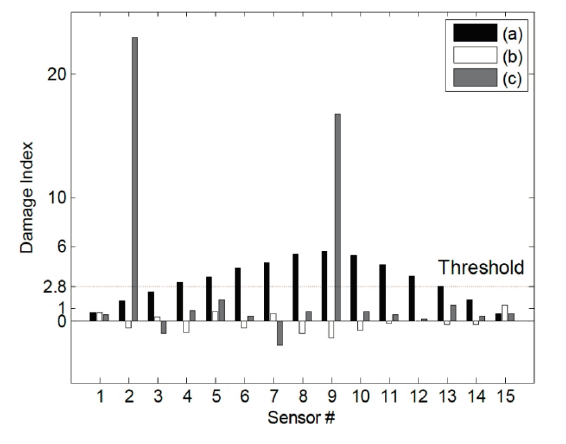
Figure 14. Estimations of the damage locations for DC2 using the three different methods: ( a ) the ULS method; ( b ) the ULS curvature method; and ( c ) the NULS curvature